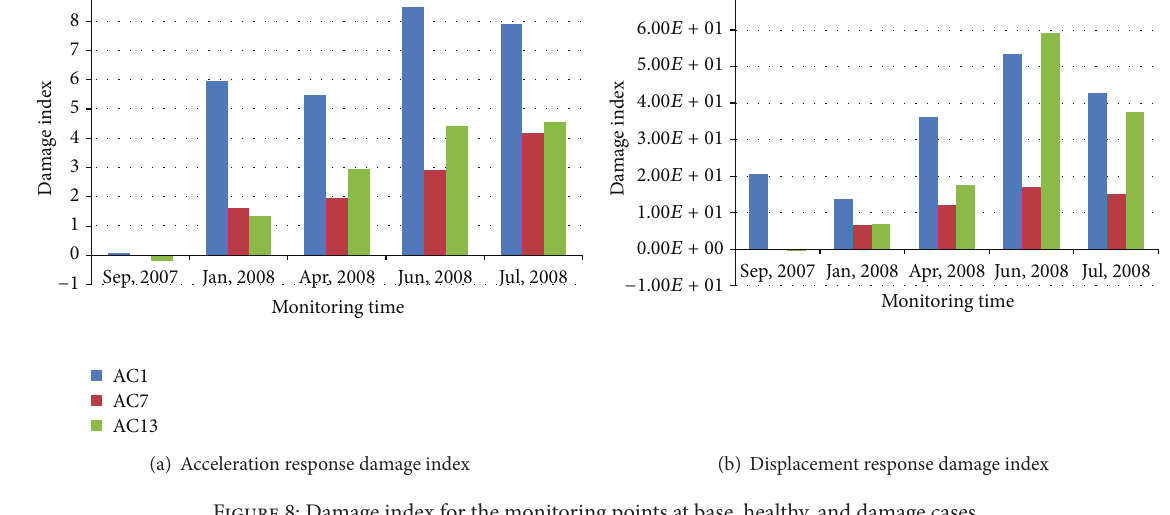
Figure 8: Damage index for the monitoring points at base, healthy, and damage